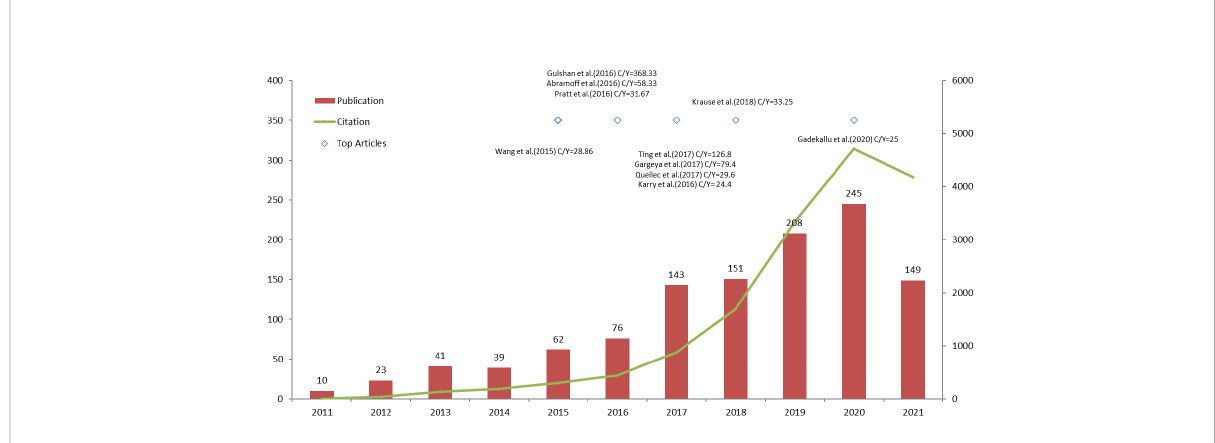
FIGURE 2 Trend analysis of publications and